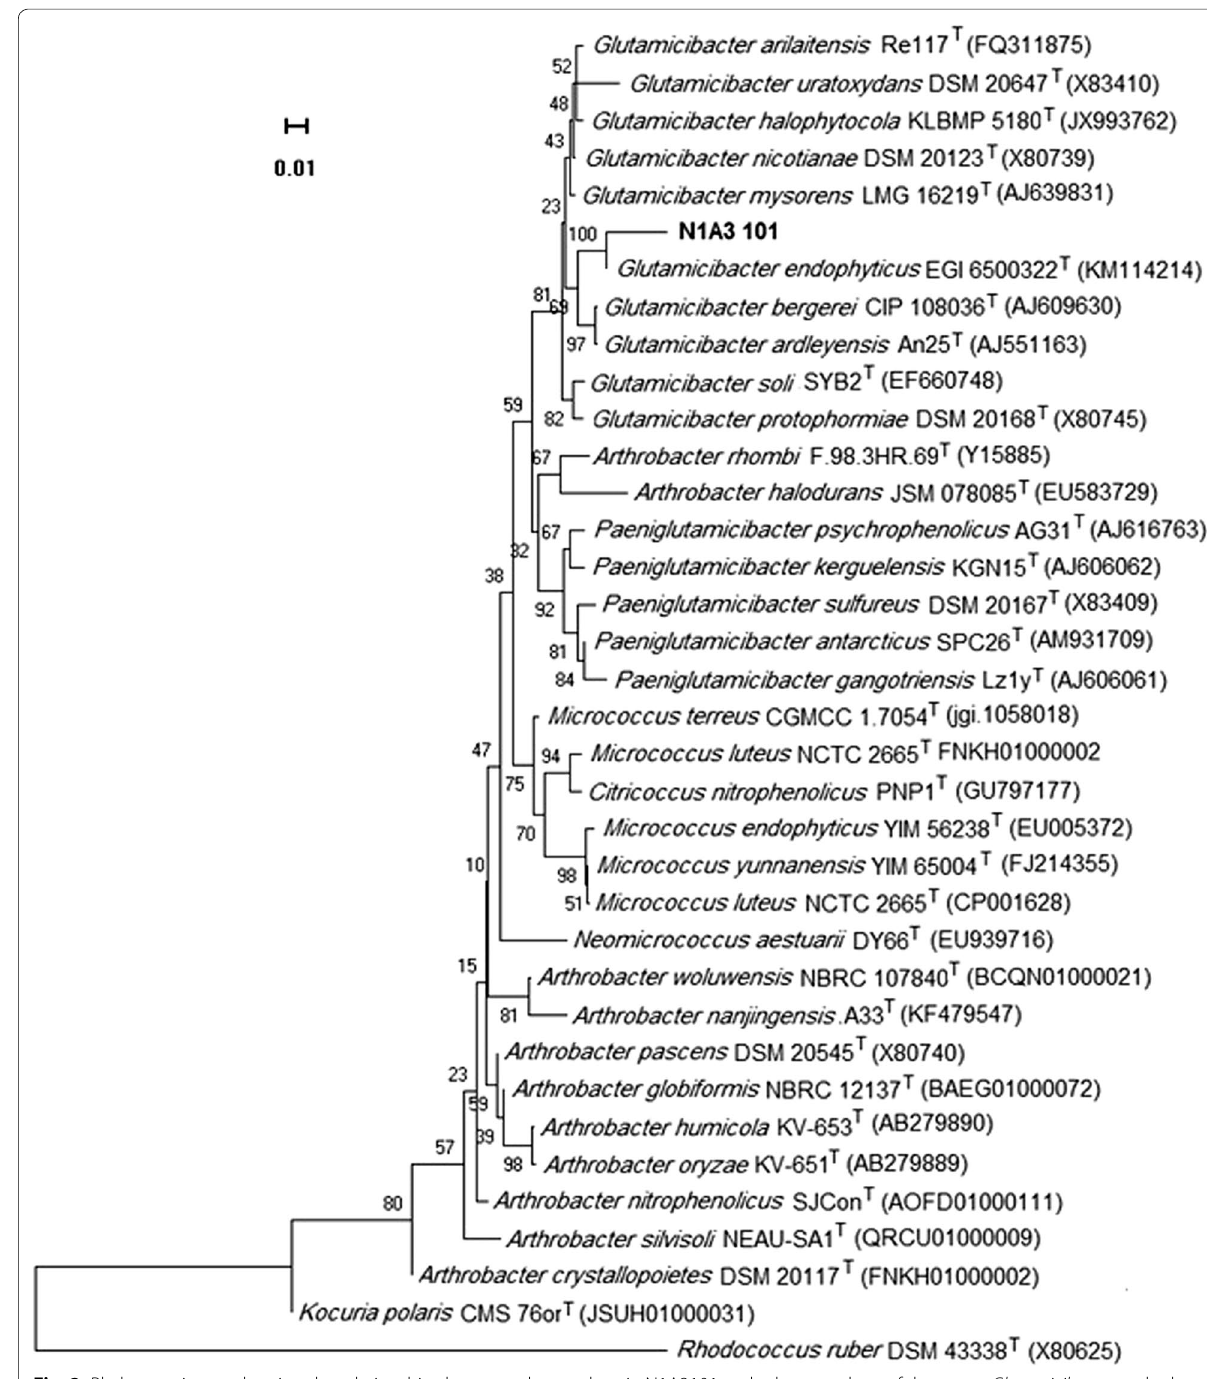
Fig. 2 Phylogenetic tree showing the relationships between detected strain N1A3101 and other members of the genus Glutamicibacter and other related genera. The phylogenetic tree was generated using the Neighbour-joining method based on the Tamura-Nei model. Numbers at nodes are bootstrap values based on 1000 replicates. The sequence of 16S rRNA from Rhodococcus ruber DSM 43338 T was used as the outgroup. Type strains are indicated by a superscript T. The scale bar indicates a genetic distance of 0.01 substitutions per nucleotide